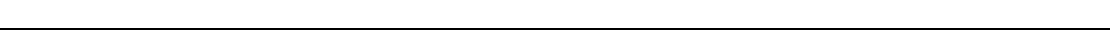
Fig. 6 The Numb PTB/Pon A1B3 complex forms liquid droplets and undergoes constant dynamic exchanges both in vitro and in living cells. a The time- lapse images showing the co-localization of iFluor TM 488-Pon A1B3 and Cy3-Numb PTB in the droplets with enriched concentrations. The enlarged images at right show that small droplets can grow and merge into larger ones as time goes on. b FRAP analysis of Cy3-Numb PTB droplets in vitro showing the exchange kinetics of the protein in droplets with the surrounding aqueous solution (see also Supplementary Movie 4). The red curve at right represents a FRAP recovery curve by averaging signals of 23 droplets with similar sizes each after photobleaching. Time 0 refers to the time point of the photobleaching pulse. All data are represented as mean ± SD. c Representative images showing co-expression of GFP-Pon A1B3 and Cherry-Numb PTB in HeLa cells produce multiple bright puncta containing both fl uorophores. Dashed boxes show the zoomed-in regions. d Numb-Pon-binding de fi cient Pon A1B3 mutants (N139A,Y154E, N169A,F186E, 4M, and 6M) or Numb PTB mutant (C90W,G192D) showing signi fi cantly decreased puncta formation when compared to the WT proteins ( n = number of batch of cultures with >820 cells counted for each batch). Specimens ’ statistics are presented as mean ± SEM; *** p < 0.001 and **** p < 0.0001 using one-way ANOVA with Tukey ’ s multiple comparison test. e Representative time-lapse FRAP images showing that GFP-Pon A1B3 signal within the puncta recovered within a few minutes (see also Supplementary Movie 6). f FARP analysis of GFP-Pon A1B3 in puncta of Hela cells. The green curve represents the averaged FRAP data of 23 puncta from 23 cells. Time 0 refers to the time point of the photobleaching pulse. All data are represented as mean ±